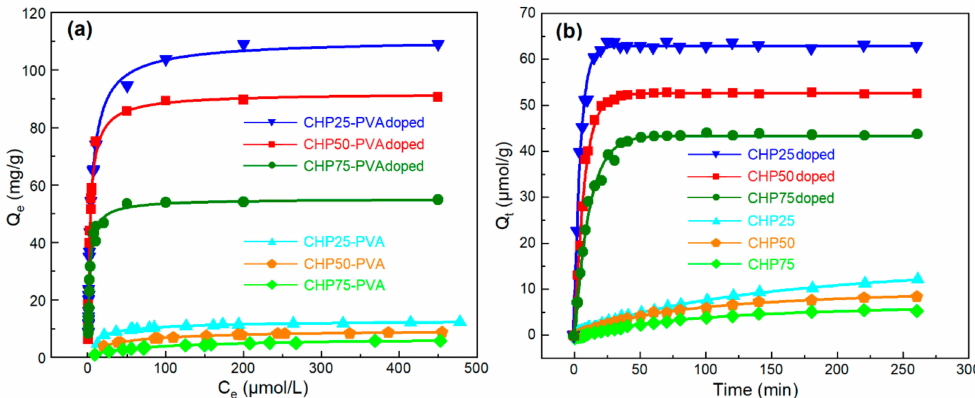
Figure 6. Equilibrium dye uptake of fluorescein by PANI-based composite materials at 298 K and pH 7: ( a ) equilibrium isotherm according to the Sips model in their film form; ( b ) kinetic profiles fitted to the pseudo-first (PFO) for the doped specimens and to pseudo-second order (PSO) model for undoped samples in their powder